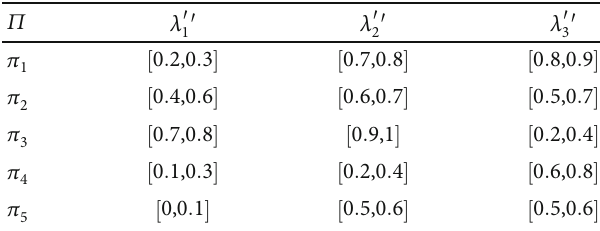
Table 2: The second positive pole membership intervals.